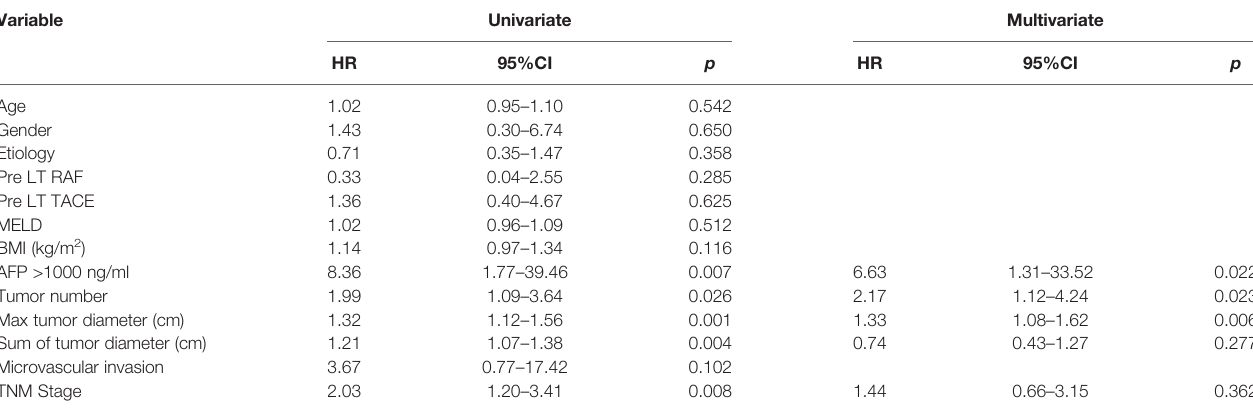
TABLE 1 | Risk factors for HCC-related death on univariate and multivariate Cox regression analysis.